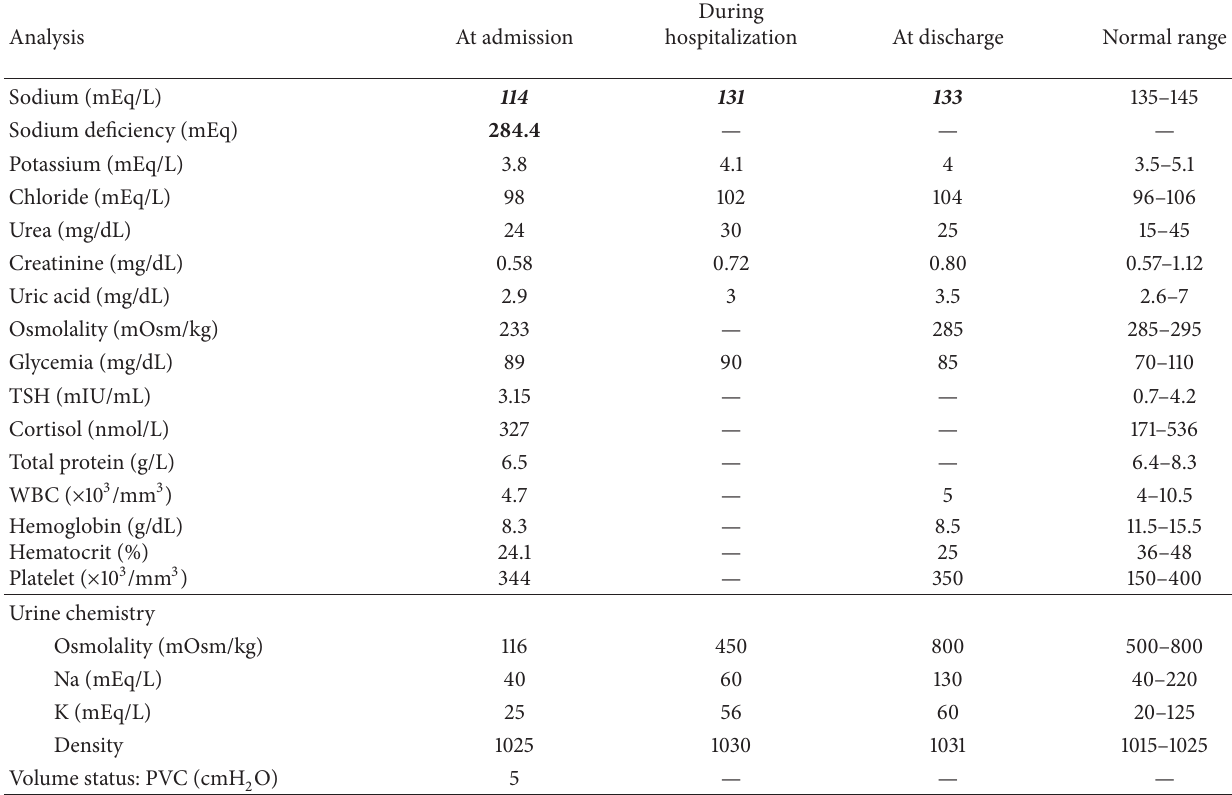
Table 1: Laboratory results at admission and in